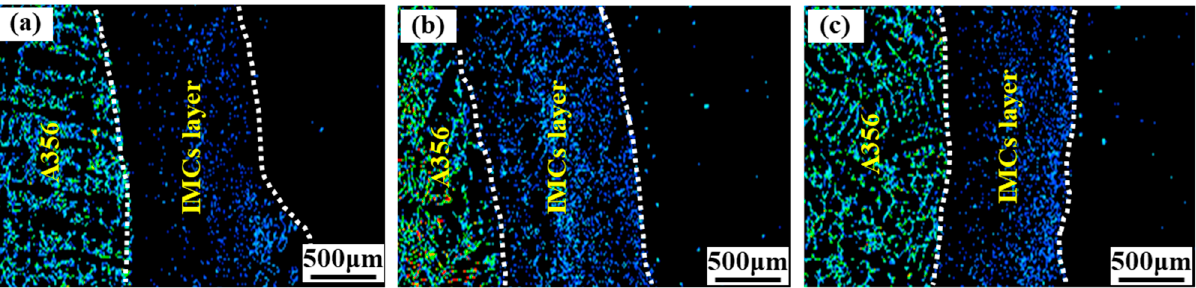
Figure 5. The distributions of the Si element in the Mg–Al bimetals prepared with different conditions: ( a ) without vibration; ( b ) with the vibration acceleration of 0.3 g; ( c ) applying the vibration acceleration of 0.9 g.